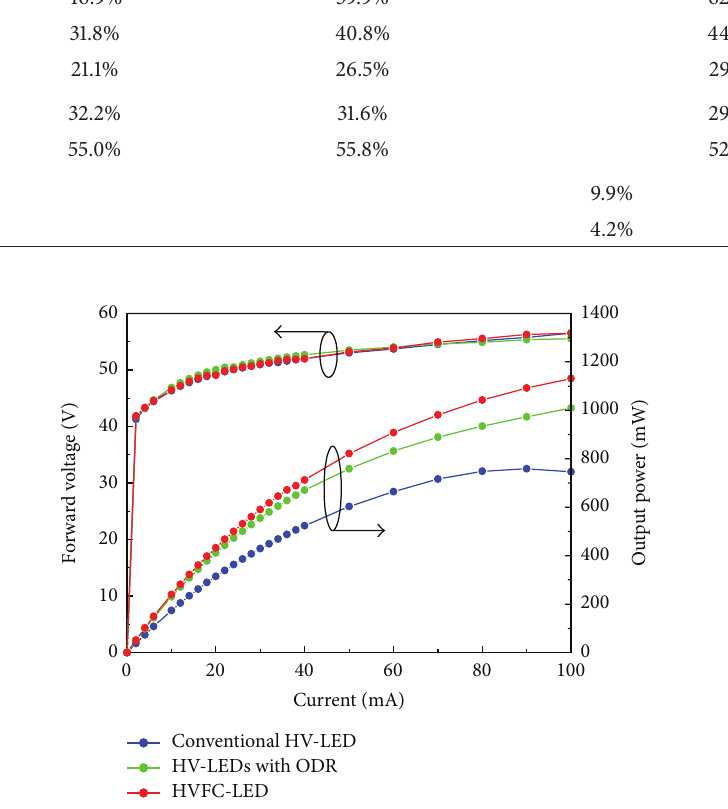
Figure 3: Forward voltage and light output power as a function of current for the three LEDs under pulse current injection.